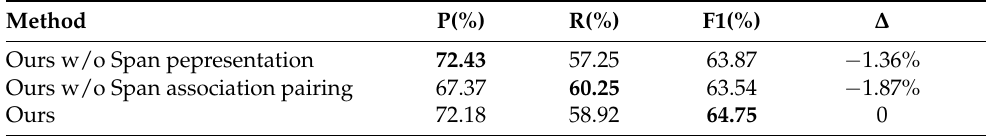
Table 4. Results of ablation experiments on the model on the ECPE task. The maximum value is marked in bold.